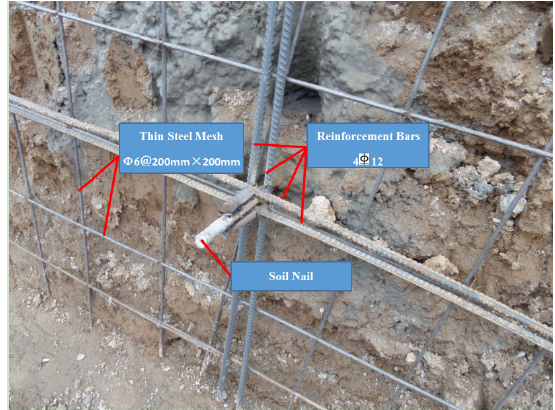
Figure 3. The enhancement configuration of the facing.